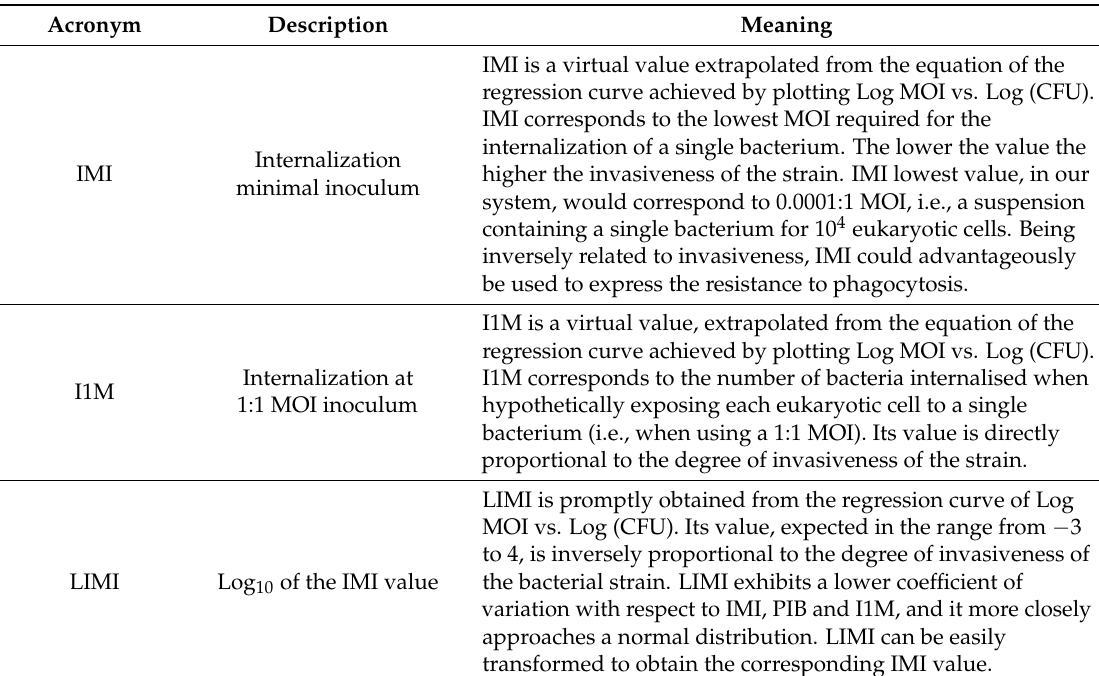
Table 4. Newly proposed parameters for expressing the invasiveness of bacterial